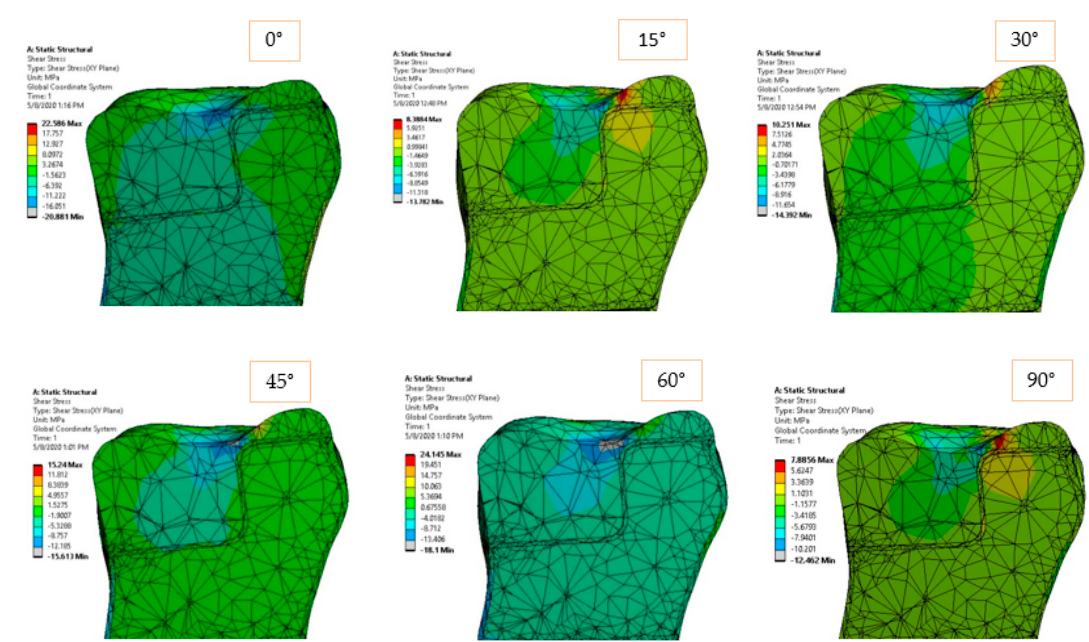
Figure 13. Shear stress in XY plane for 170 N load and 0 ◦ –90 ◦ loading direction. The stress values at the sampling points are given in Tables 6 and 7, corresponding to the directions applied force. Based on these, the stress variation plots were obtained, which were further compared to the mechanical strength of the dental materials, as in the case of the inlay model. The mean and standard deviation represent the average aspect of the stress in the considered sampling points of the interface. Table 6. Stress values in restoration ceramic.